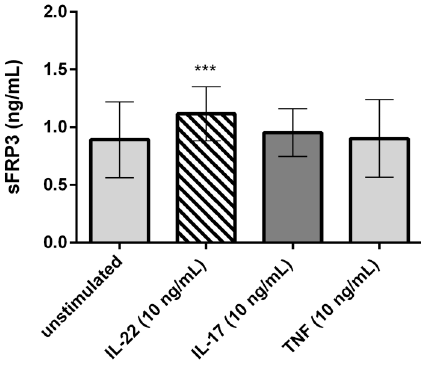
Figure 3. Secreted Frizzled-related proteins (sFRP3) in the supernatant of fi broblast-like synoviocytes (FLS) culture super- natant (n=11) treated with interleukin (IL)-22, IL-17, or tumor necrosis factor (TNF- a ), all of them at a dose of 10 ng/mlL, and in untreated controls. Data are reported as the means ± SD from three independent repetitions. ***P o 0.001 vs unstimulated FLS